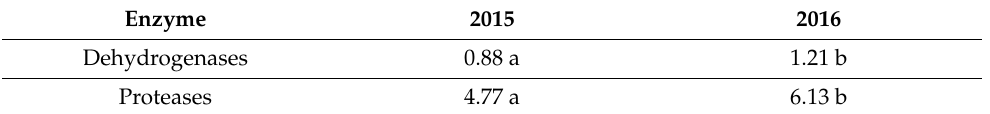
Table 5. Dehydrogenase (cm 3 H 2 24 h − 1 kg − 1 dm) and protease (mg of tyrosine h − 1 kg − 1 dm) activity in the years 2015 and